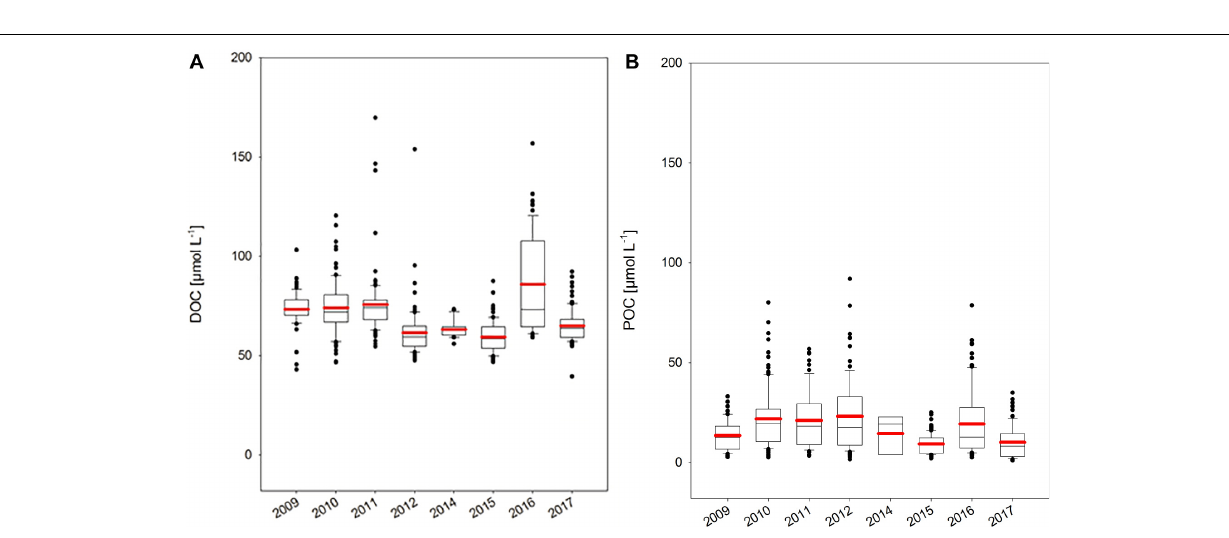
FIGURE 6 | (A,B) Inter-annual variability of DOC and POC concentration in the HAUSGARTEN area. Box plots show 25–75th percentile of data within the box, error bars 10th and 90th percentile, outlying data as well as the mean (red line) and median